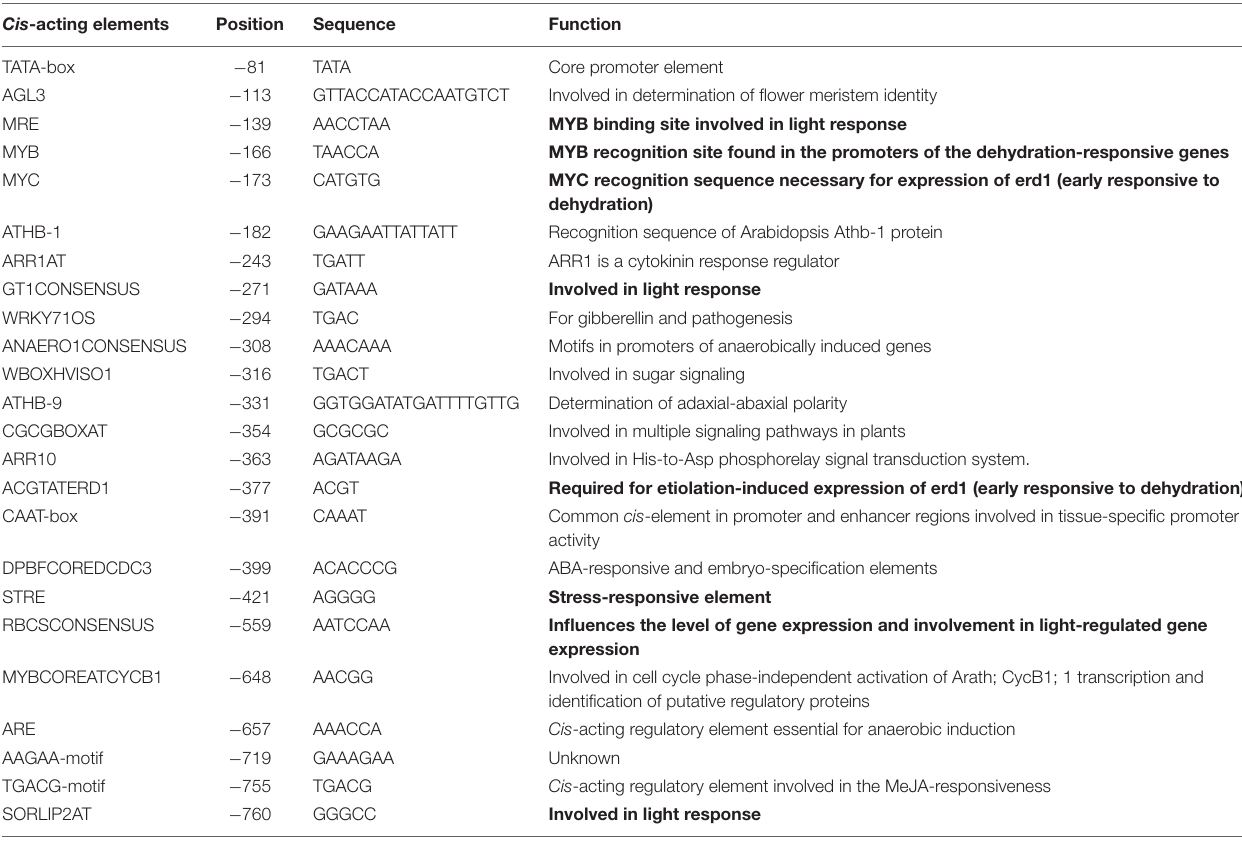
TABLE 2 | Selected cis -acting motifs and their location in the 5 (cid:48) -upstream sequence of ShSLD . Cis -acting